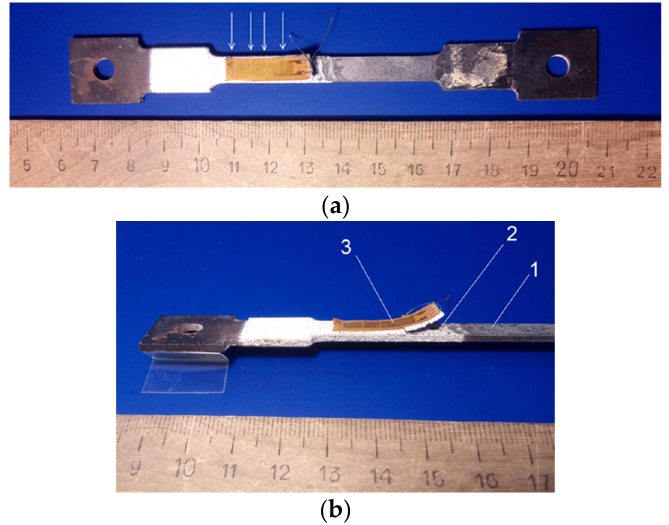
Figure 2. Specimen with two-layer coating after tensile test, the cracks marked by vertical arrows in the uppermost ceramic layer ( a ); and side view of delaminated coating marked: 1, substrate; 2, metal bond coat; 3, top ceramic coat with attached strain gauge ( b ).